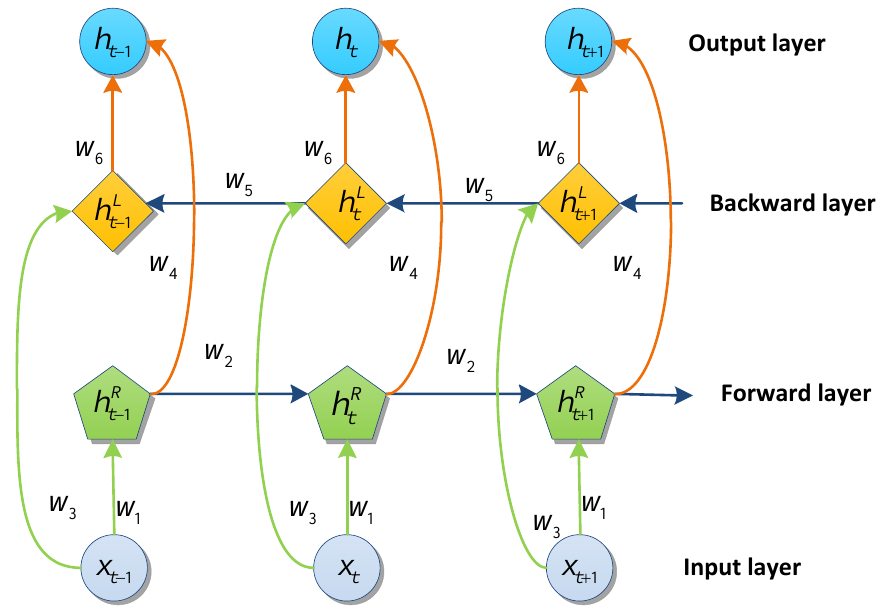
Figure 4. BILSTM loop structure diagram.